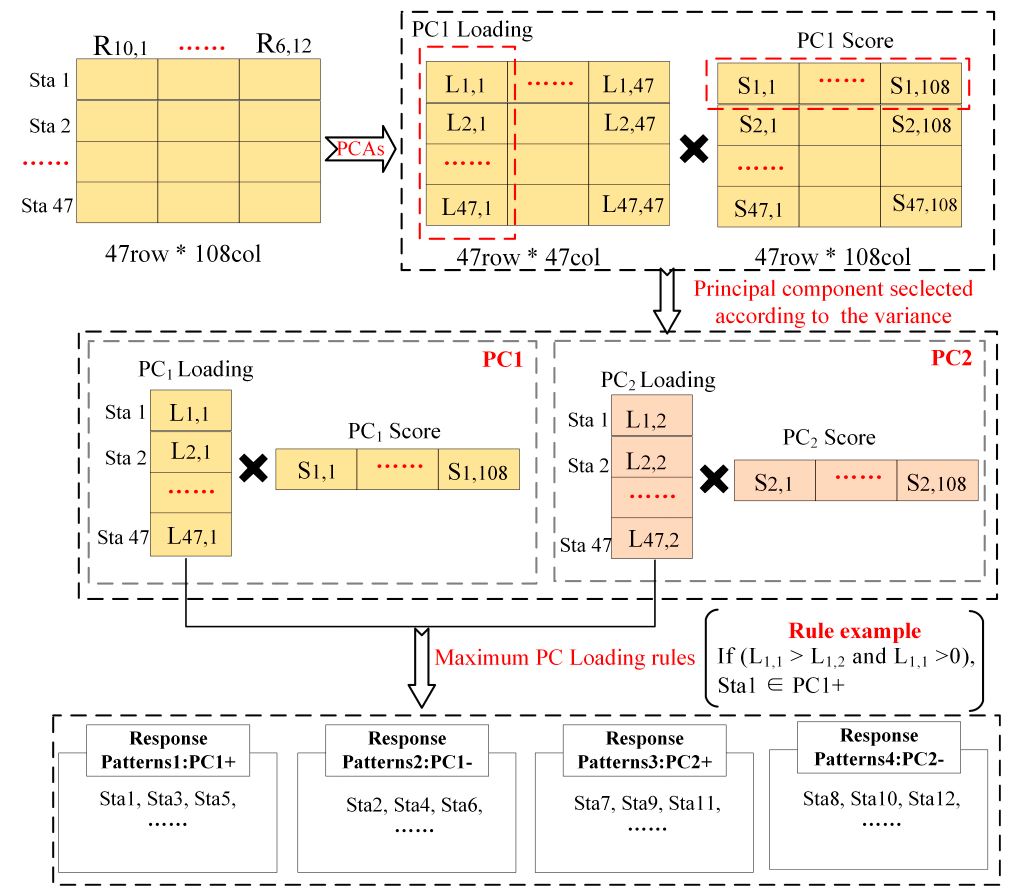
Figure 5. The follow chart of the PCAs method in our study. “Sta” is the abbreviation of “Station”, “PC” is the abbreviation of “principal component”.